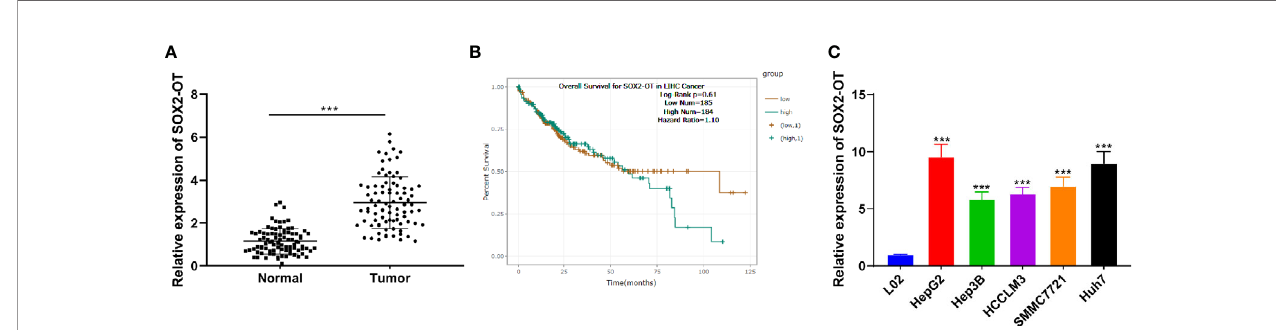
FIGURE 1 | SOX2-OT was elevated in HCC. (A) SOX2-OT expression in HCC tissues and normal tissues of HCC patients was detected by RT-qPCR, N = 87; (B) The relationship of SOX2-OT expression and prognosis was analyzed through TCGA visualization Starbase website (http:starbase.sysu.edu.cn); (C) SOX2-OT expression in HCC cells and normal hepatocytes was examined by RT-qPCR. The cell experiment was repeated three times independently, and the data were all metrological data. All data were shown as mean ± standard deviation. T test or one-way ANOVA was used for data analysis, followed by Tukey ’ s test. *** P < 0.001.